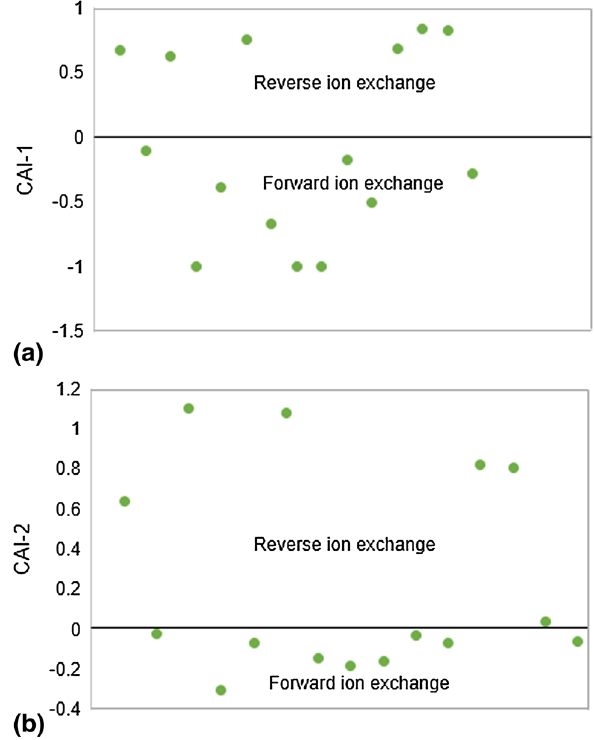
Fig. 11 a , b Chloro-alkaline indices (CAI-1, CAI-2) depict the domi- nance of forward ion exchange in releasing the alkali metals and chlo-